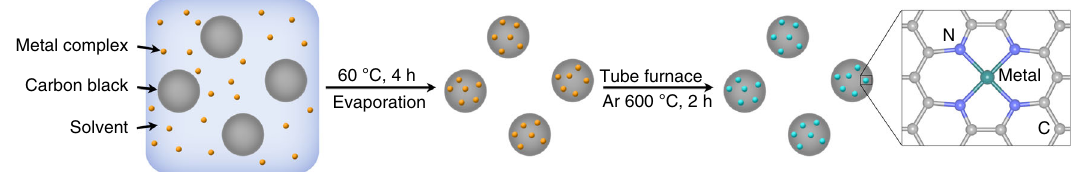
Fig. 1 The universal synthesis procedure. Metal single-atom catalysts (M-SACs) are prepared in two